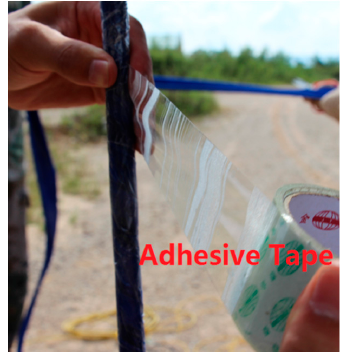
Figure 5. Protective adhesive tape layer.